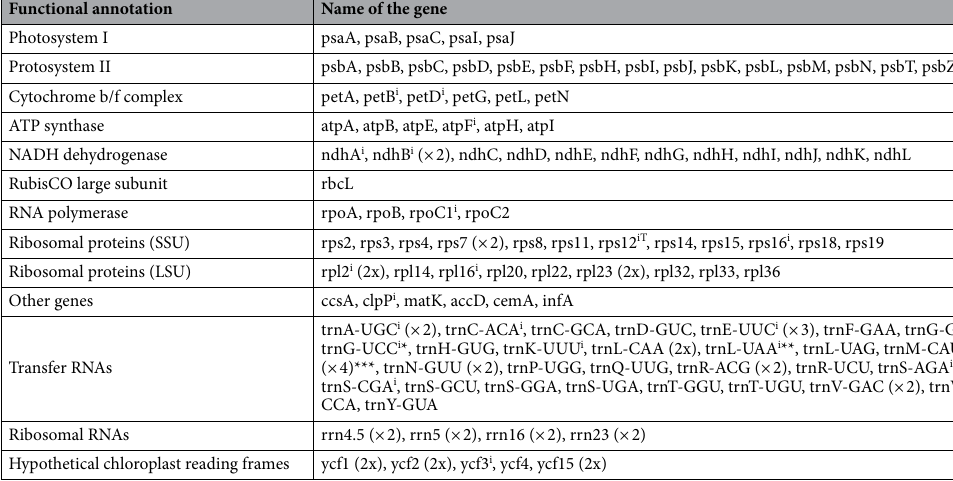
Table 2. List of genes annotated in the six assembled plastomes: Calophyllum brasiliense , Caraipa heterocarpa : Clusia panapanari , Kielmeyera appariciana , K. coriacea , and Mahurea exstipulata . i Genes with introns. T Transpliced gene. *Present only in M. exstipulata . **Absent in C. brasiliense. ***Only three copies in M. exstipulata